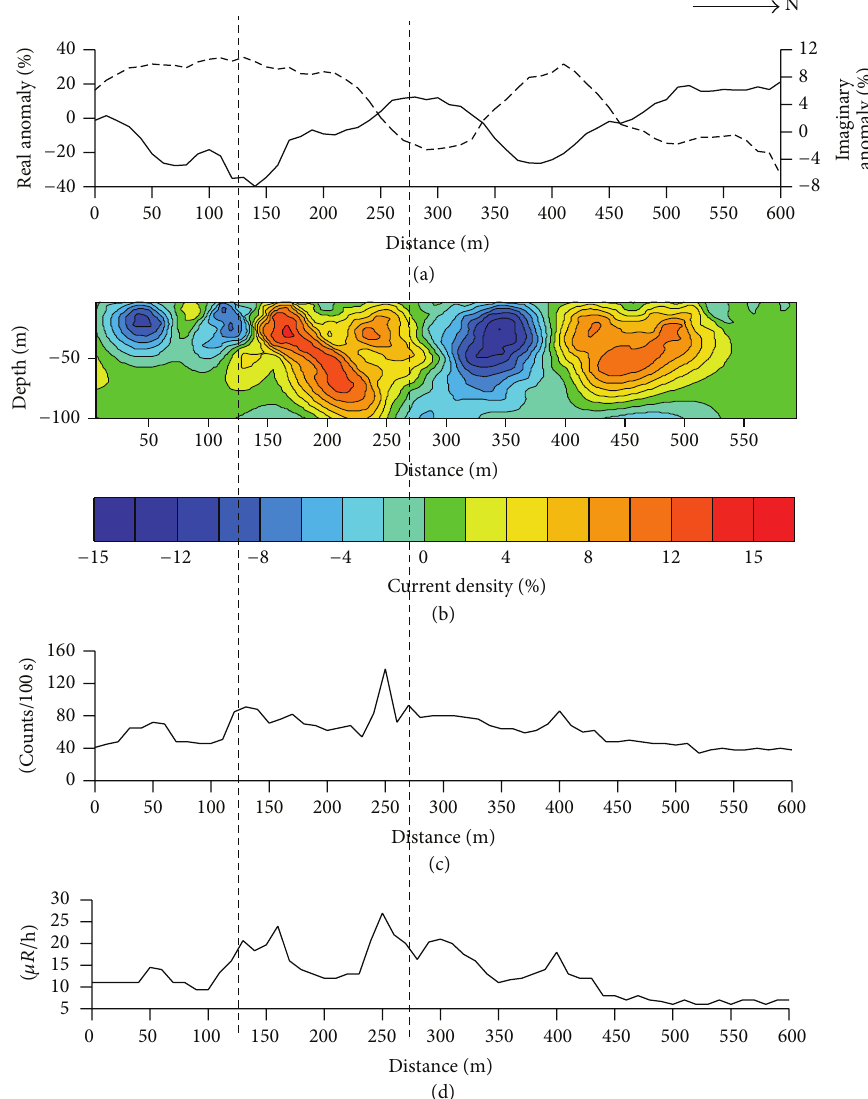
Figure 7: Profile P1600: (a) VLF anomaly (real by solid line and imaginary by dashed line), (b) pseudo current density cross-section along profile P1100, and (c) surface radiation and (d) surface gamma